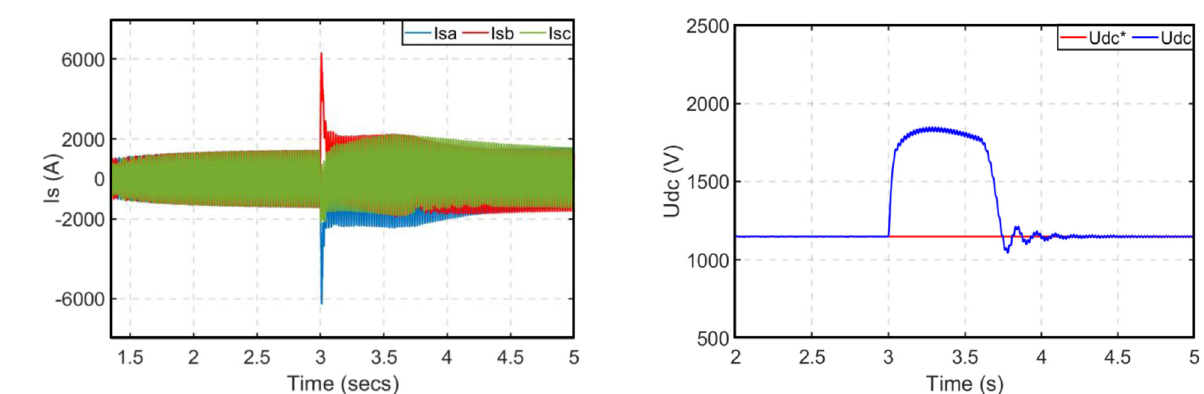
Fig. 10 Stator current evolution